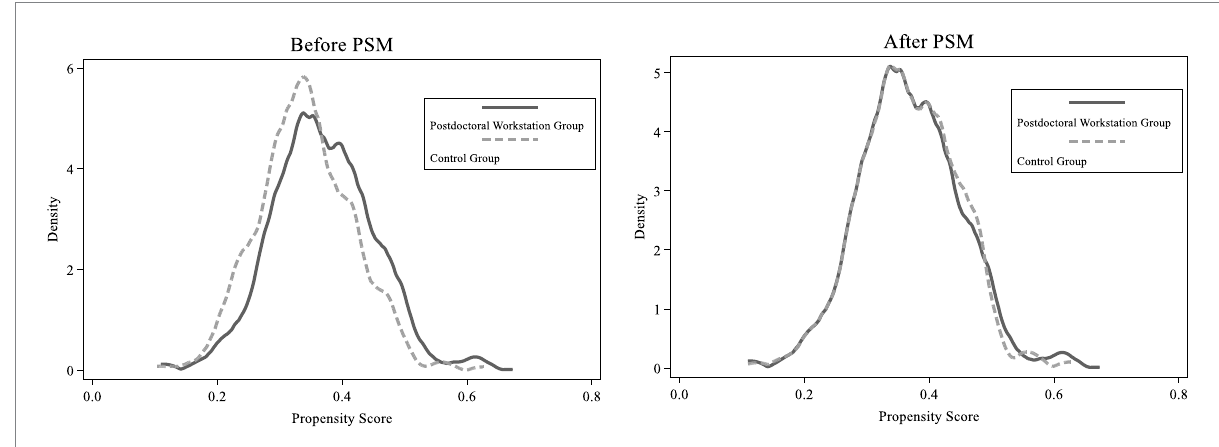
FIGURE 4 Kernel Density Plot. This figure reports the kernel density function after PSM for the treatment and control groups. Specifically, the probability density functions of the two groups of samples retained after PSM are